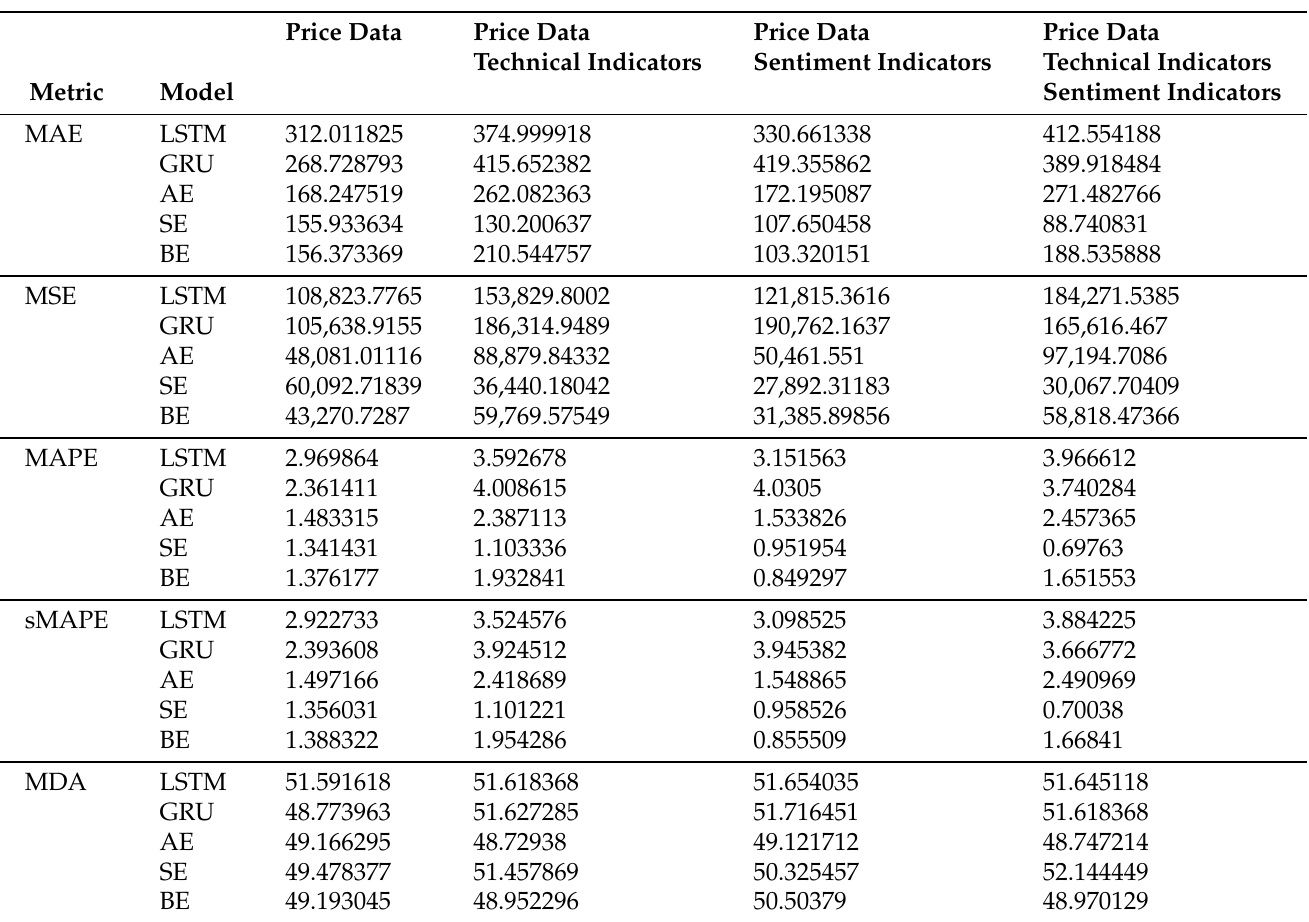
Table 4. Results of the 30 min